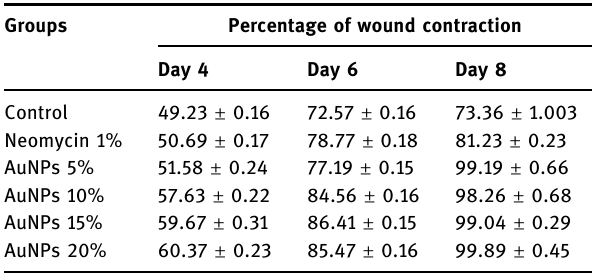
Table 1: E ff ect of AuNPs on wound contraction percentage